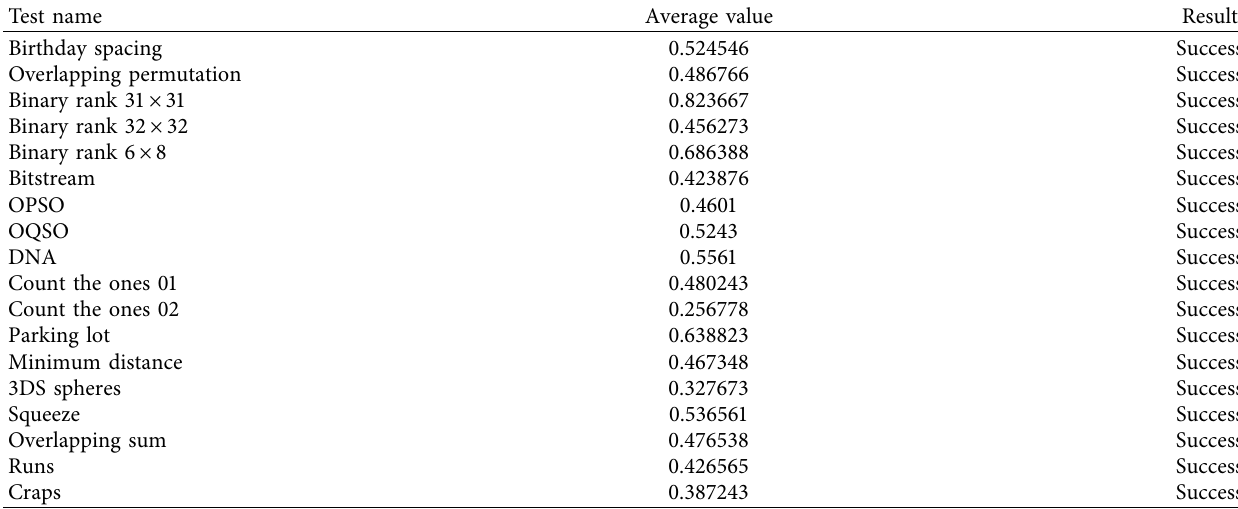
Table 7: Result of DIEHARD tests